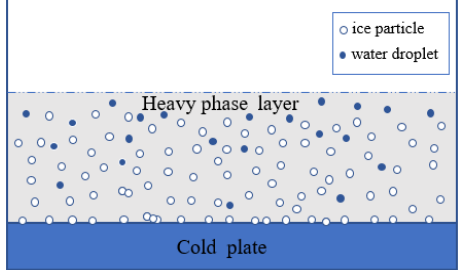
Figure 3. Illustration of heavy phase layer.